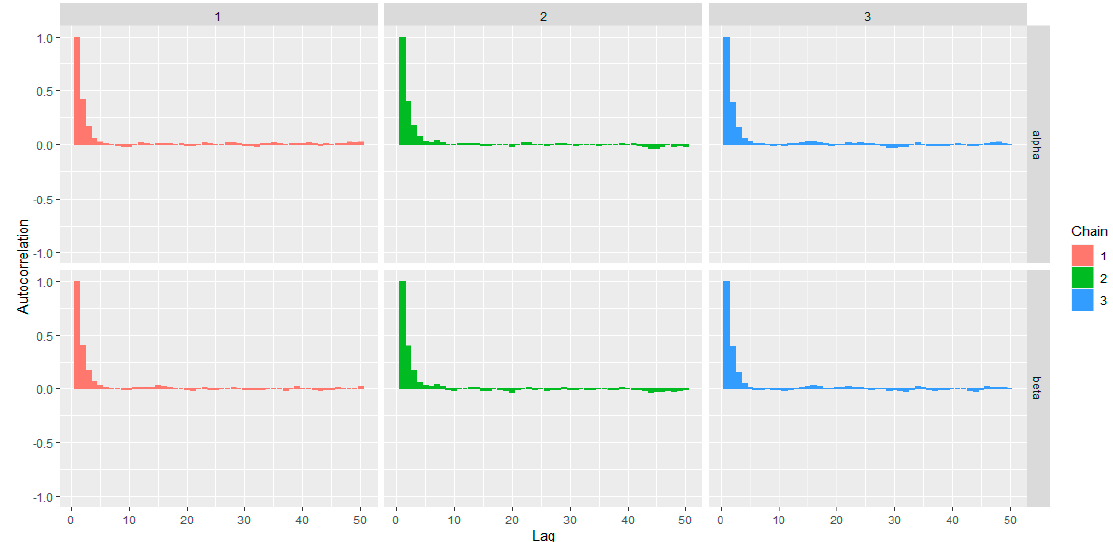
Figure 13. The AP distribution posterior parameters autocorrelation